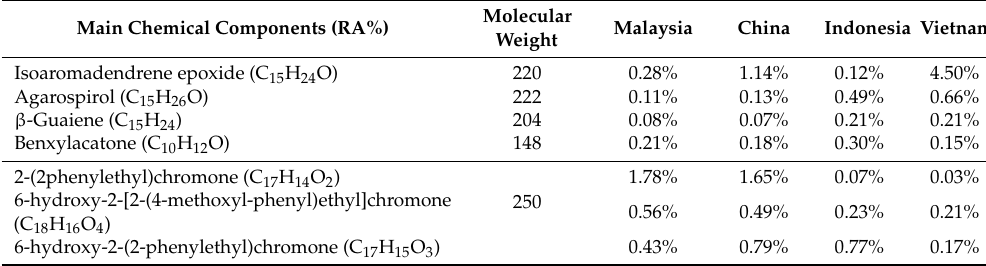
Table 3. Chemical composition analysis of agarwood from different